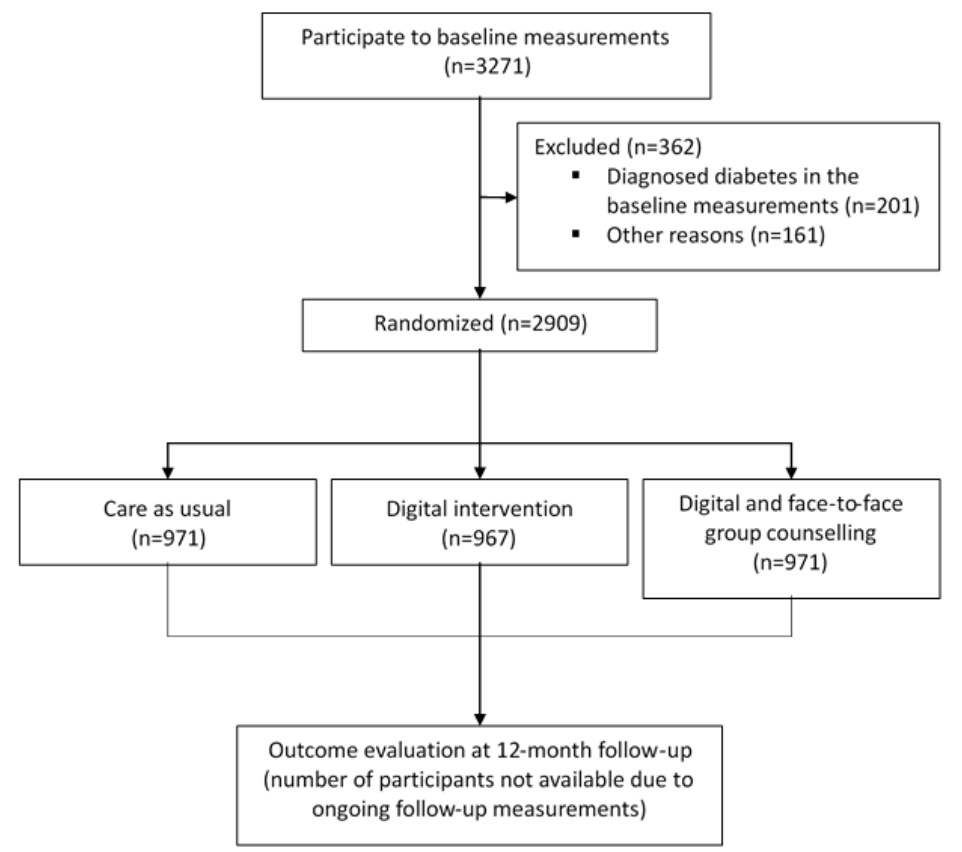
Figure 4. Flow diagram of the Stop Diabetes intervention study